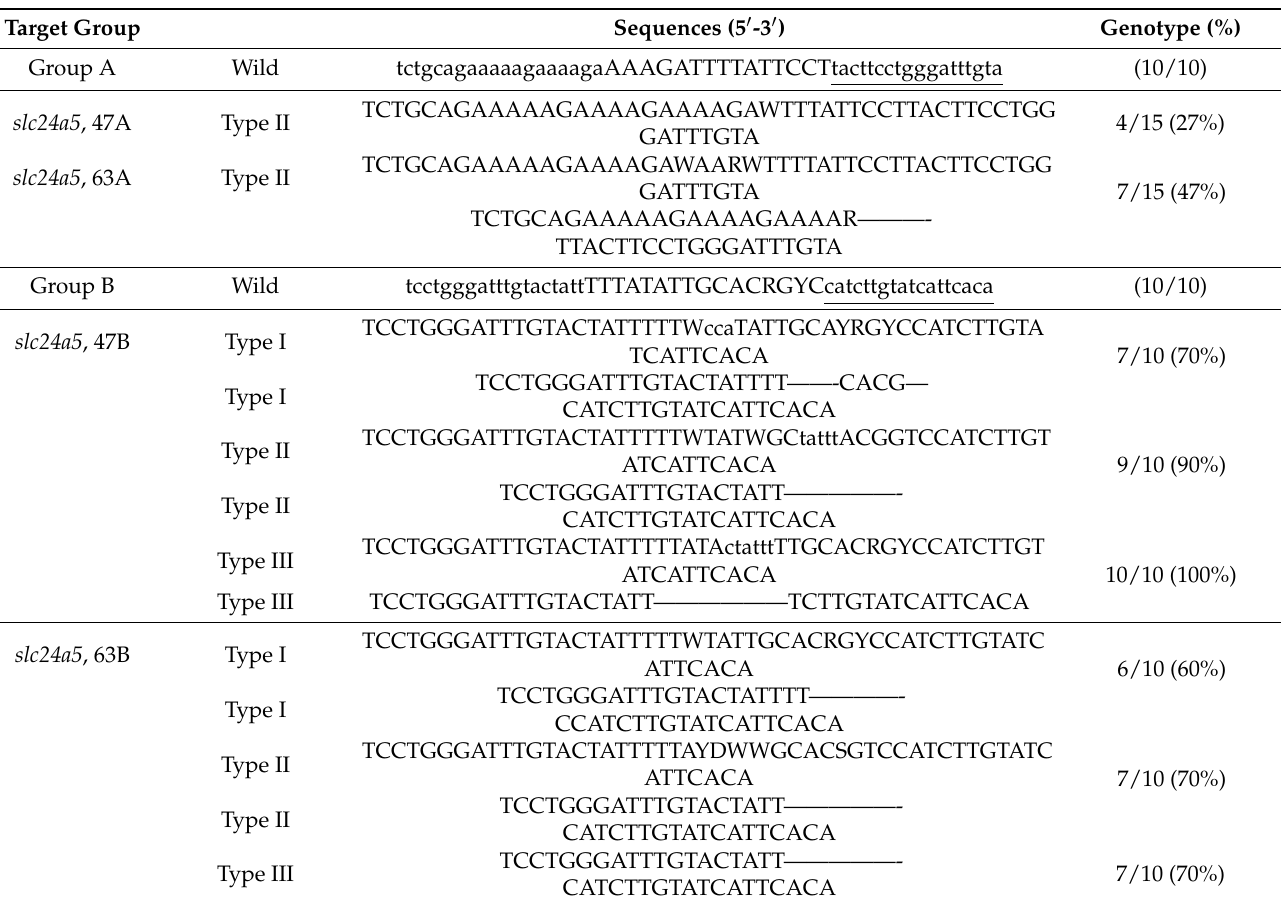
Table 3. Genotype and appearance ratio in F0 slc24a5 genetically modified by TALEN in kawakawa. Target